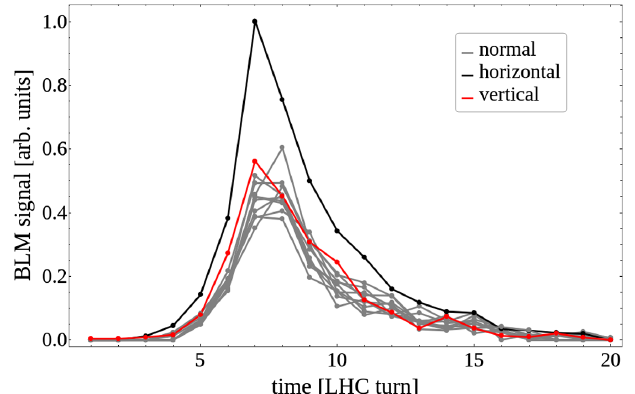
FIG. 12. Comparison of the dBLM measurement, integrated in 80 μ s bins, and the local ICBLM measurement. It shows that the rising edge agrees well, but that the dBLM signal has a slower falling edge due to delayed losses in the collimators.